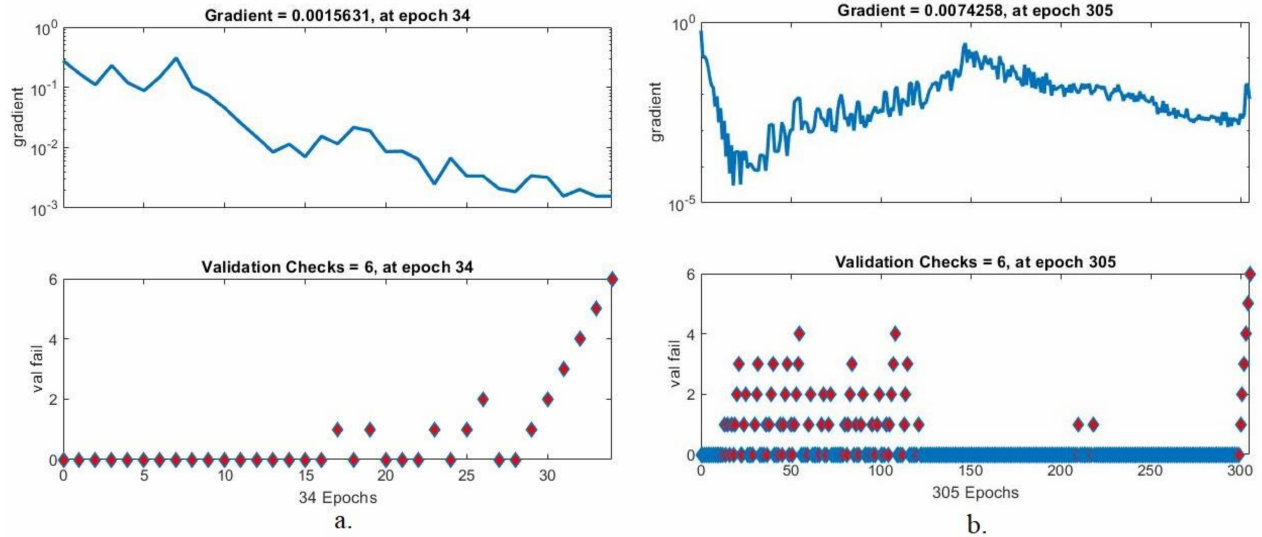
Figure 10. A display of the validation and gradient analysis for evaluating the first dataset based on mixed features of ( a ) DenseNet-121 and hand-crafted and ( b ) ResNet-50 and hand-crafted.